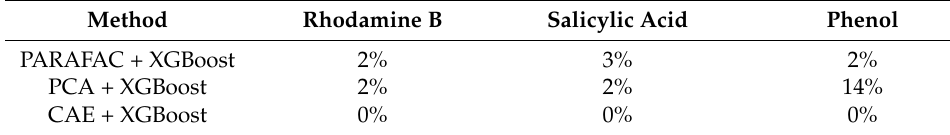
Table 3. Misreporting rate of drinking water samples to relative pollutant.